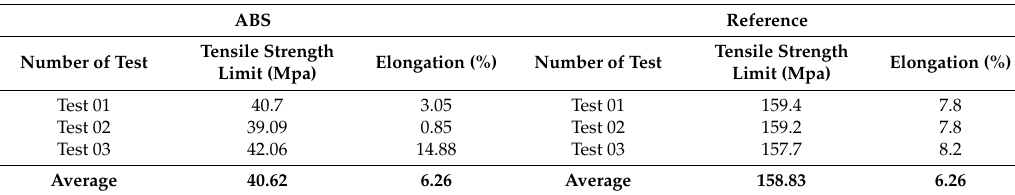
Table 2. Comparative results of tensile tests.